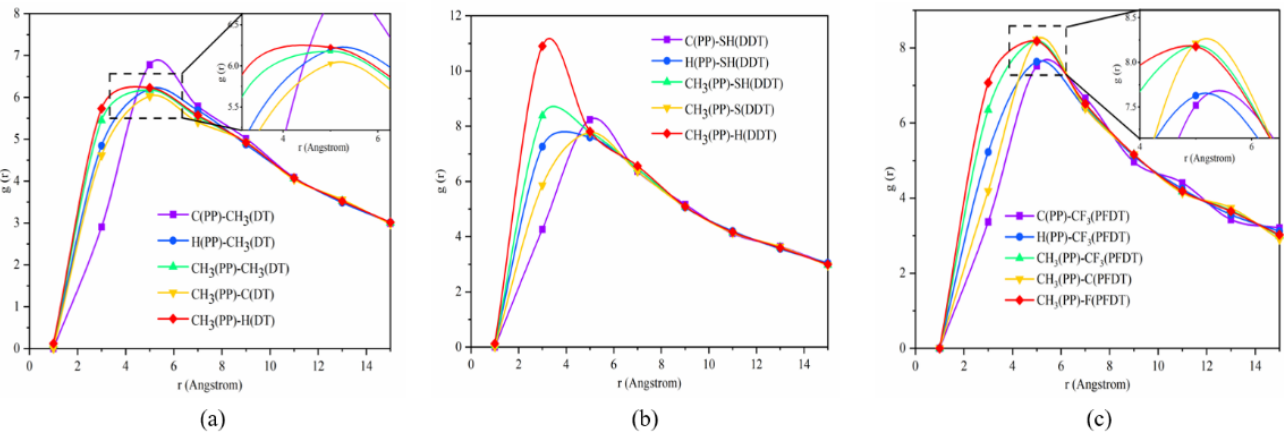
Figure 9. Radial distribution functions of the three interfaces in P (2 × 2) arrangement: ( a ) PP–DT, ( b ) PP–PFDT and ( c ) PP–PFDT.